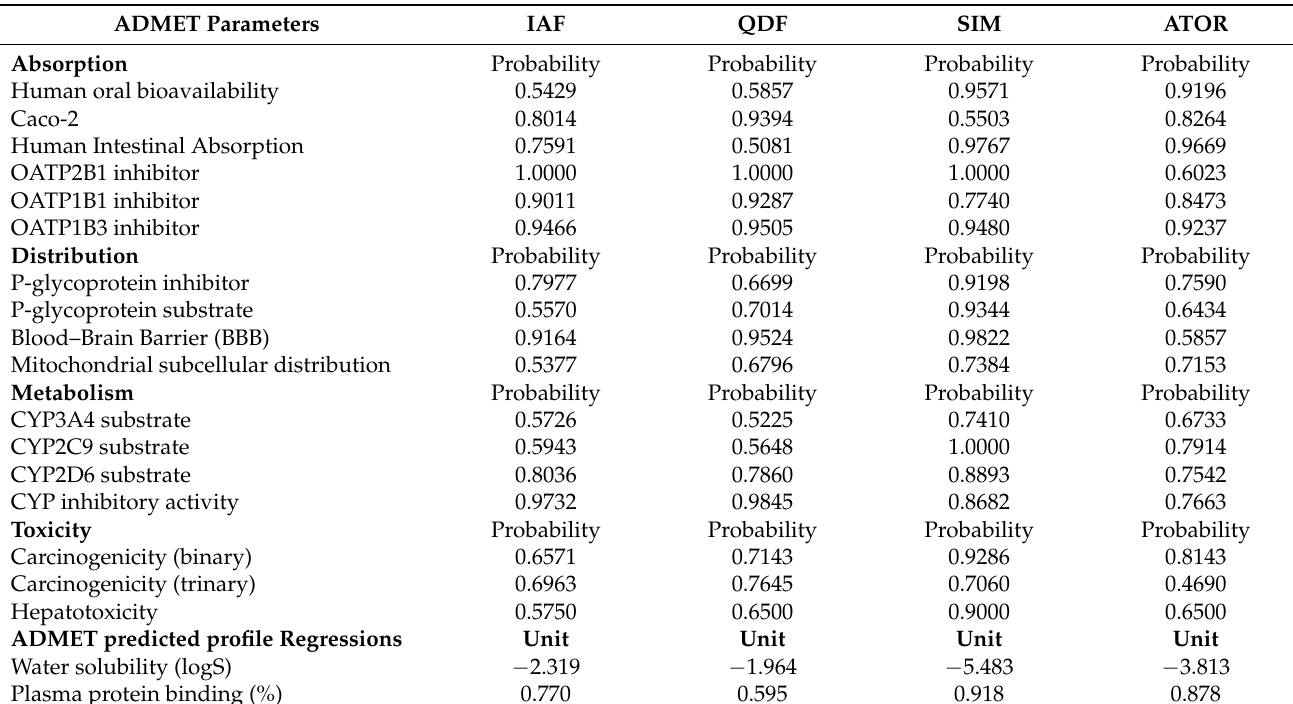
Table 3. Comparison of absorption, distribution, metabolism, excretion, and toxicity properties of the peptides and statins. ADMET